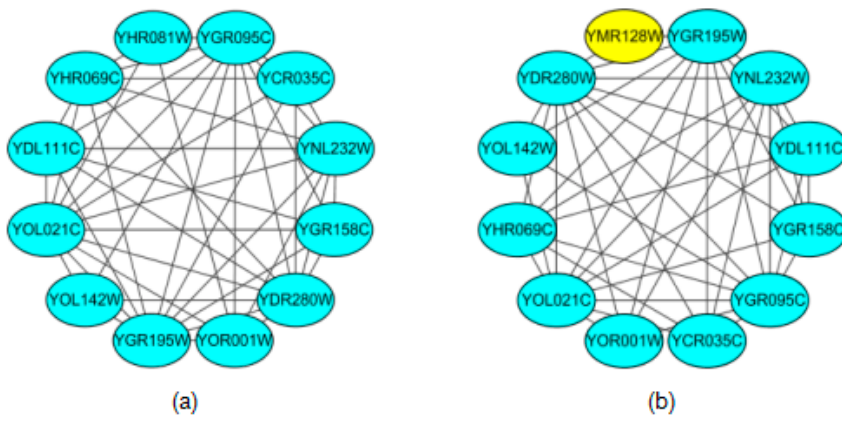
Figure 5. Visualization of a protein complex: ( a ) standard complex; ( b ) identified complex: the yellow protein represents the wrong protein; the blue proteins represent correct proteins.